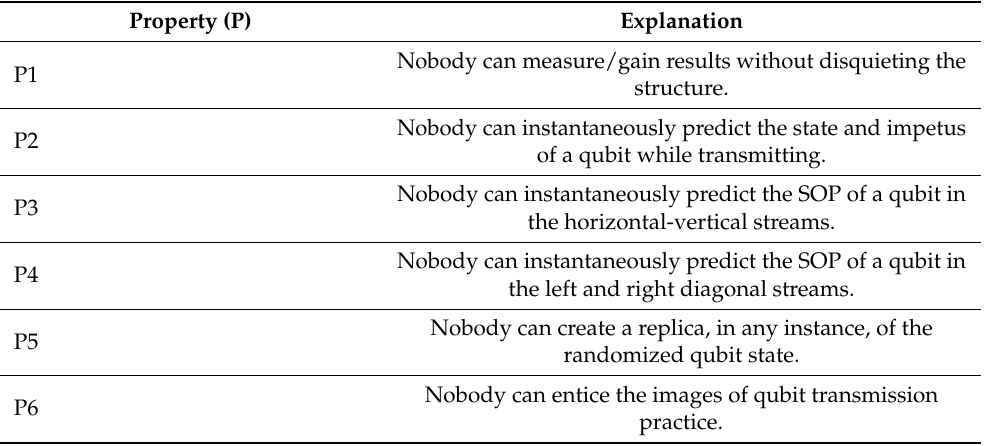
Table 2. SOPs of QKD-related qubits and associated